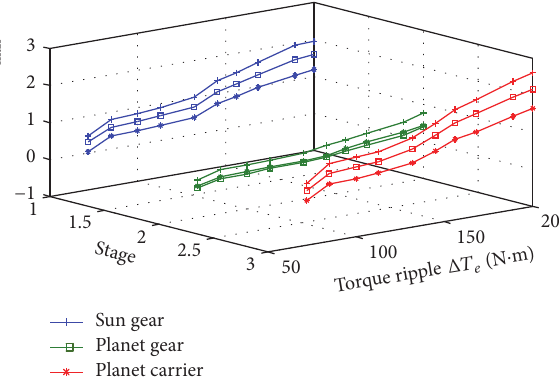
Figure 16: Influence index 𝛿 max under different torque